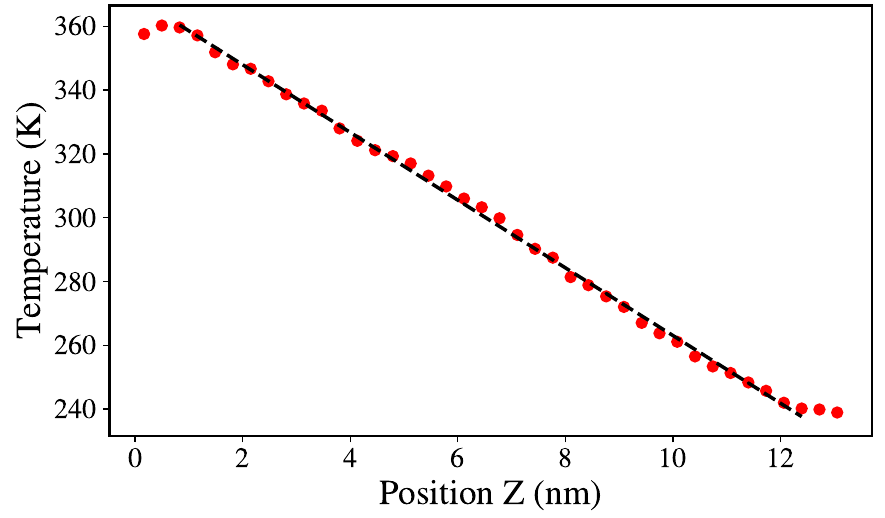
Figure 2. Temperature profile for a 20 % sp 3 NT, with 1 and 2 nm of internal and external radii, at 300 K. The dotted line shows the linear fit of the temperature